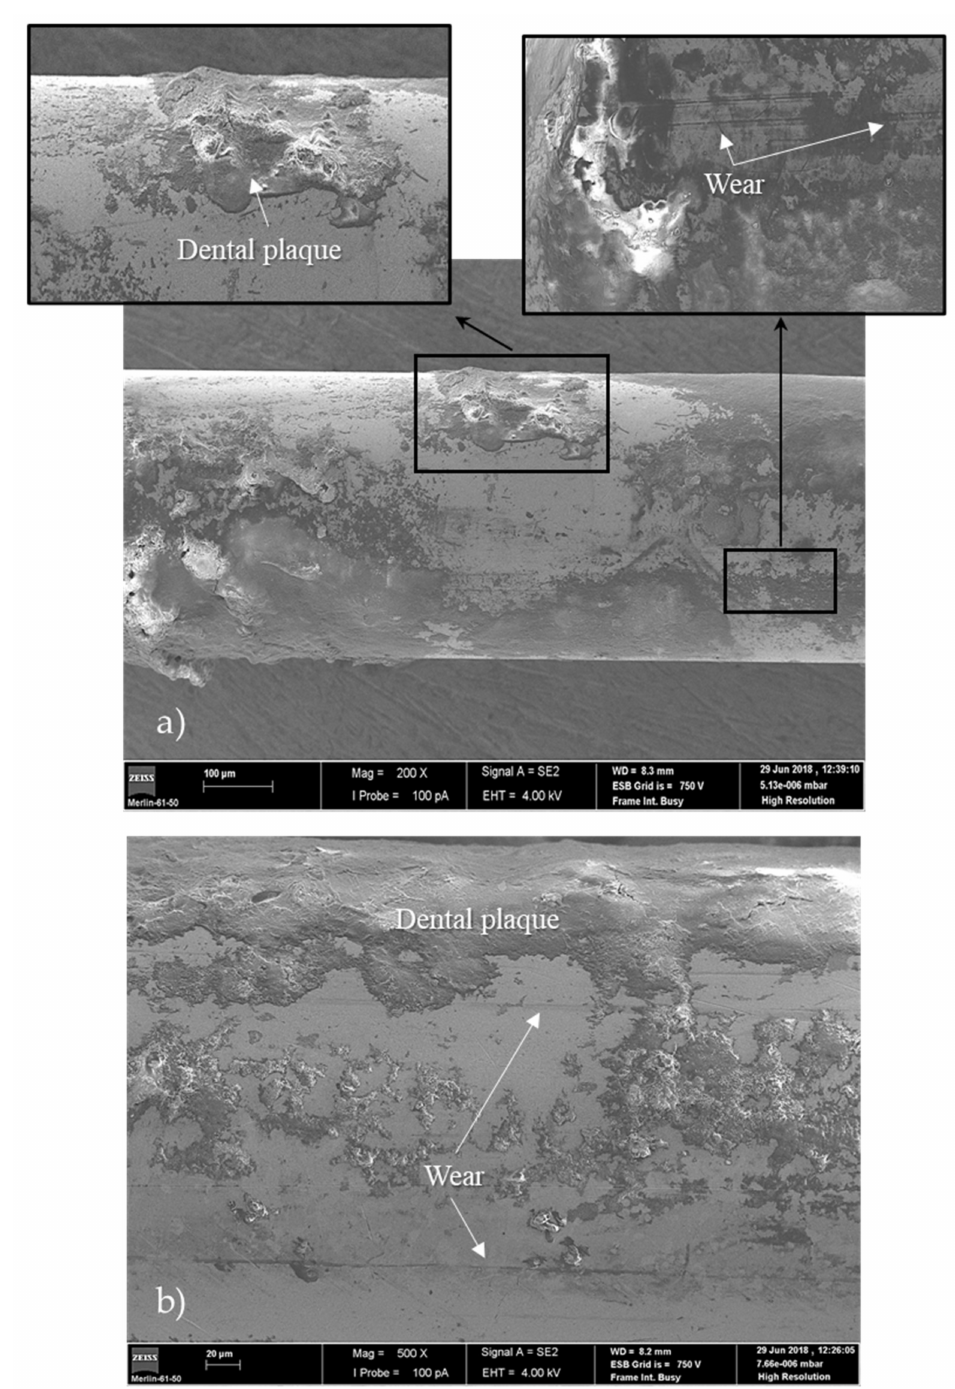
Figure 2. Scanning electron microscopy (SEM) micrographs of the NiTi archwires: ( a ) patient P12–13 weeks; ( b ) patient P3–22 weeks of intraoral